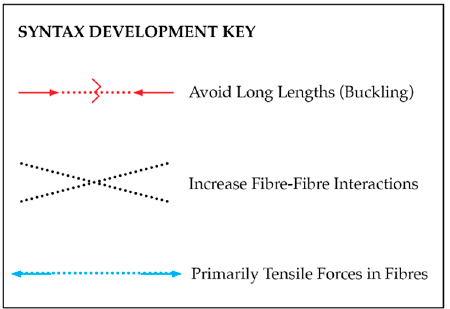
Figure 10. Fibre syntax development goals to avoid typical failure modes.